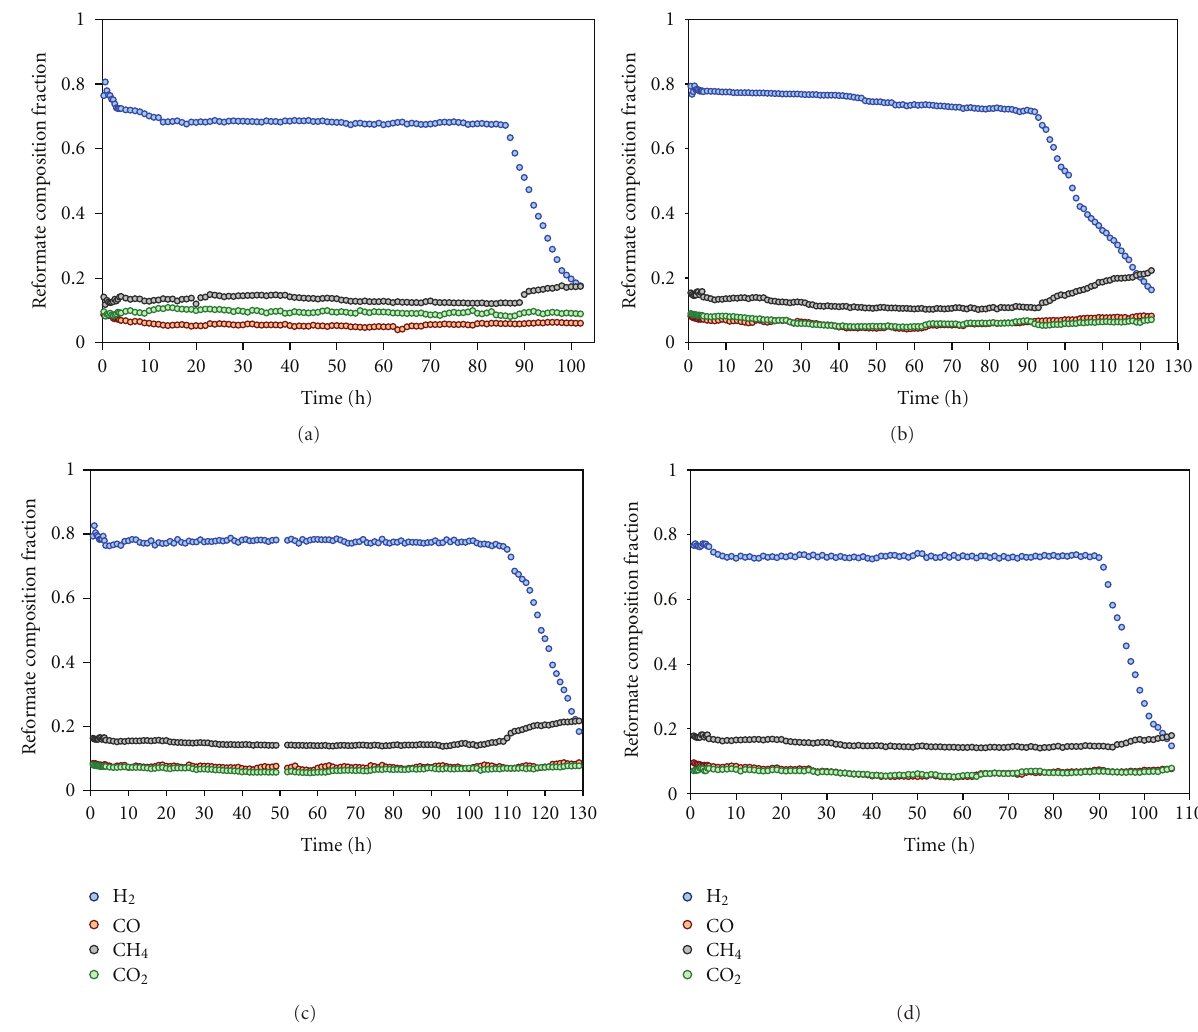
Figure 6: Composition of the reformates with: (a) RPR333, (b) RPR322, (c) RPR232 and (d) RPR223.